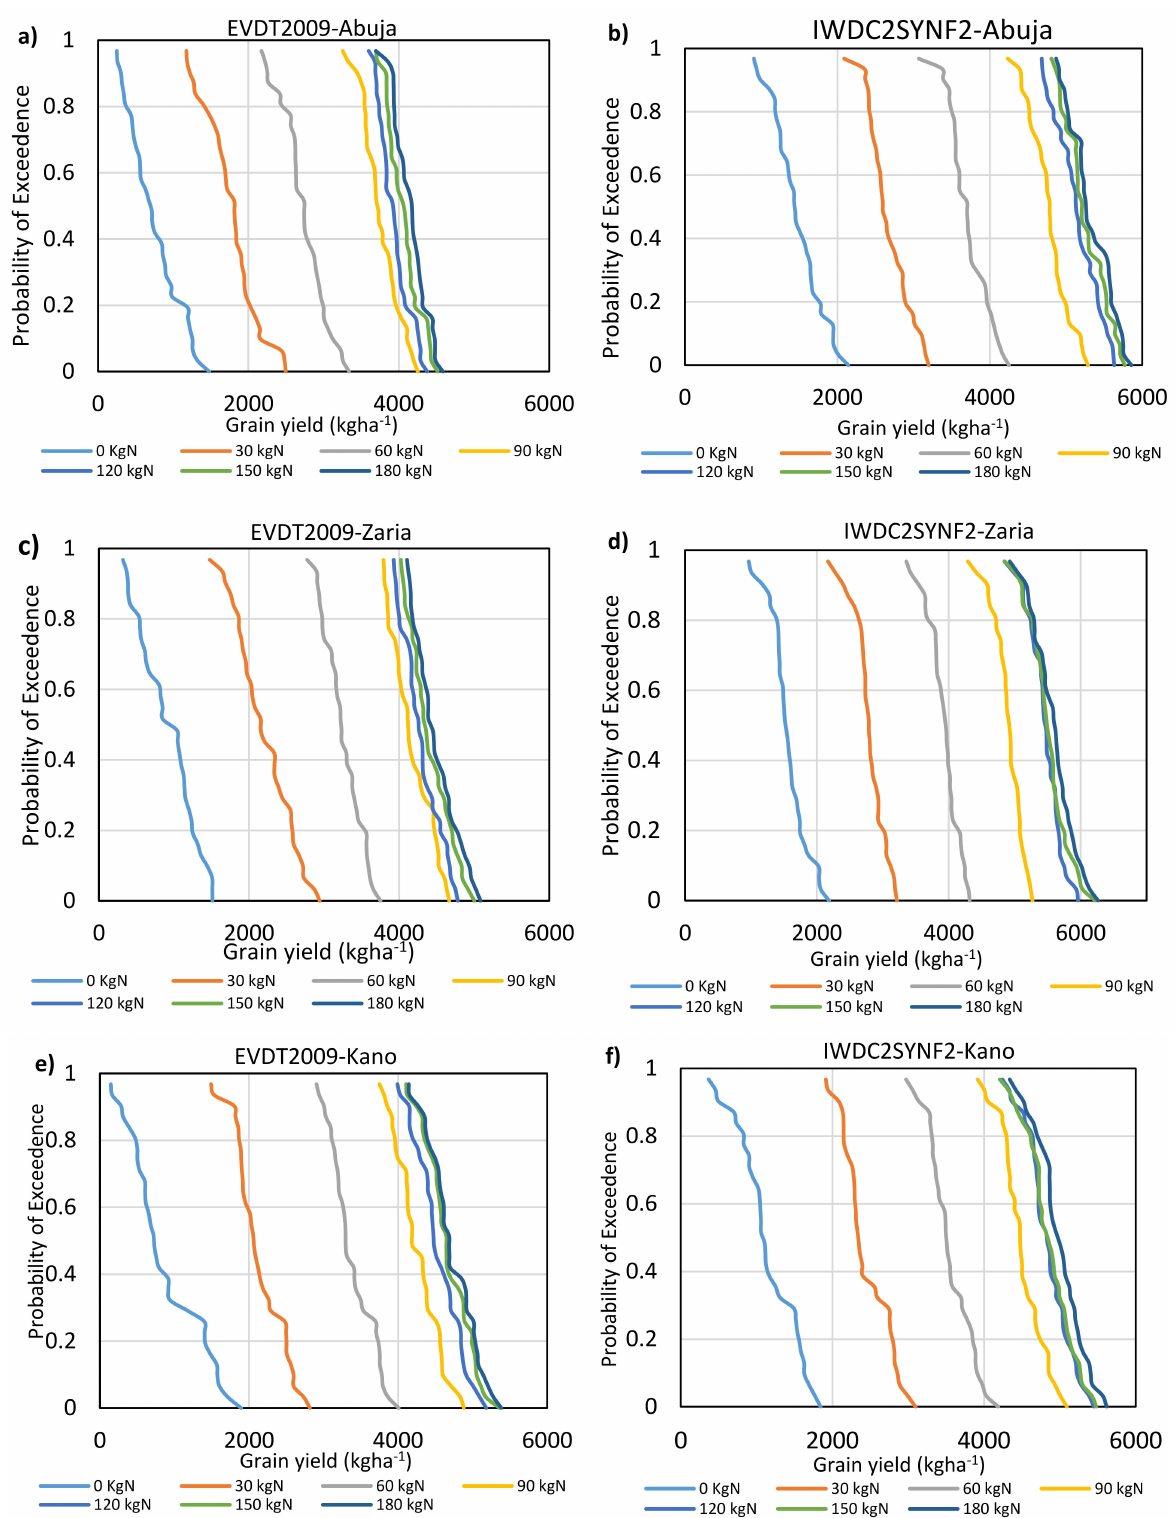
Figure 5. - Probability of exceedance for simulated grain yield of EVDT2009 and IWDC2 in Abuja ( a , b ), Zaria ( c , d ) and Zaria ( e , f ) representing three agro ecological zones under semi-arid